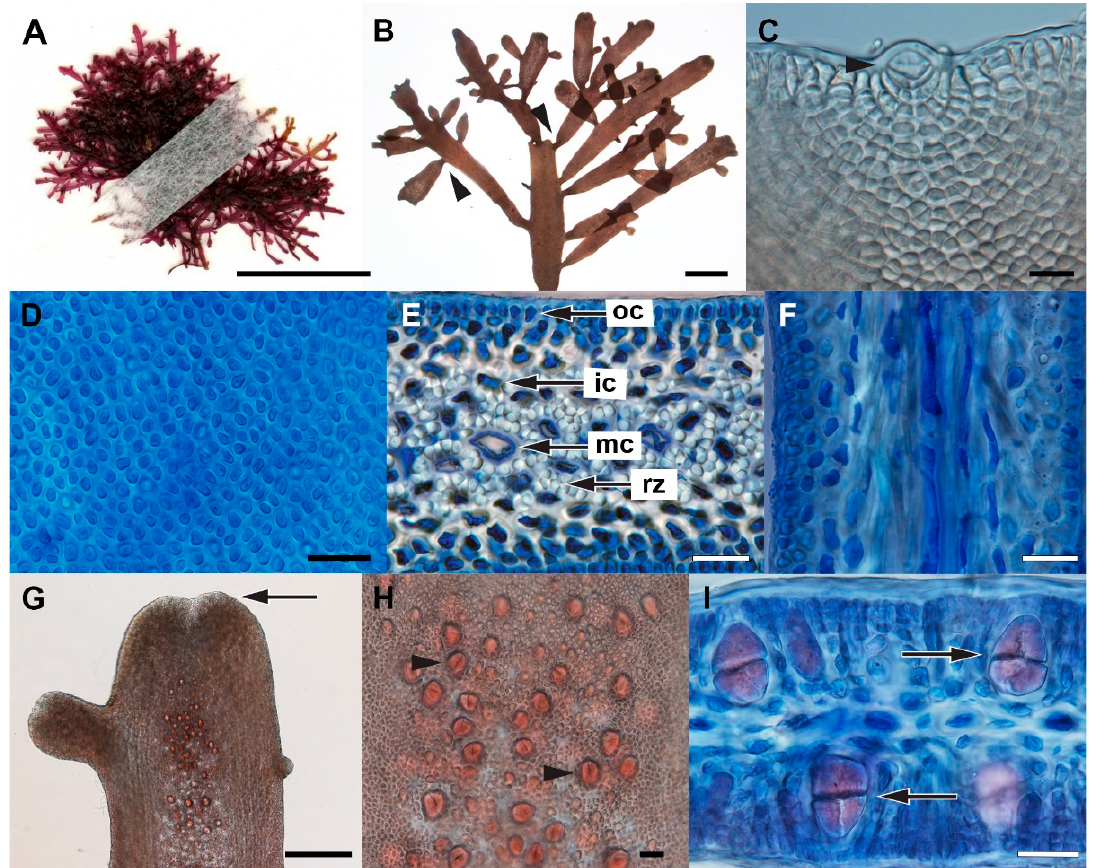
Figure 5. Gelidium sclerophyllum from southern Madagascar. ( A ) Habit; ( B ) branches flattened, arising from margin of axis, having constricted base (arrowheads); ( C ) obtuse apex of an erect axis showing an apical cell (arrowhead); ( D ) irregularly arranged outermost cortical cells; ( E ) transverse section through a middle part of erect axis showing outermost cortical cells (oc), inner cortical cells (ic), internal rhizoidal filaments (rz), and medullary cells (mc); ( F ) longitudinal section of erect axis showing medulla and cortical layer; ( G ) tetrasporangial sori having retuse apex (arrowhead) with sterile margin. ( H ) Irregularly arranged tetrasporangia (arrowheads); ( I ) transverse section through the tetrasporangial sorus showing cruciately and decussately divided tetrasporangia (arrows) arising from inner cortex. Scale bars: 1 cm ( A ), 1 mm ( B ), 200 µ m ( G ), 20 µ m ( D – F , H , I ), and 10 µ m ( C ).